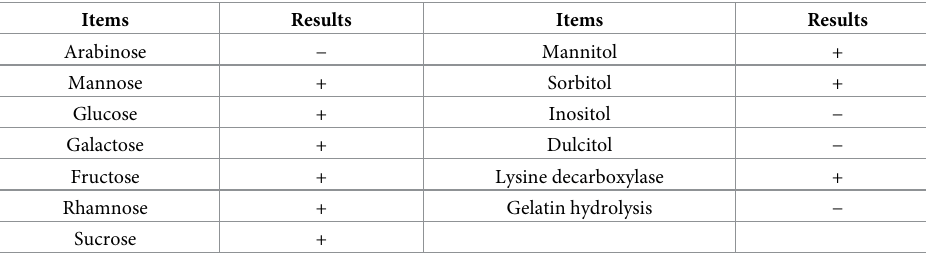
Table 3. Identification of the physiological characteristics of C . sartagoforme XN-T4 . Items Results Items